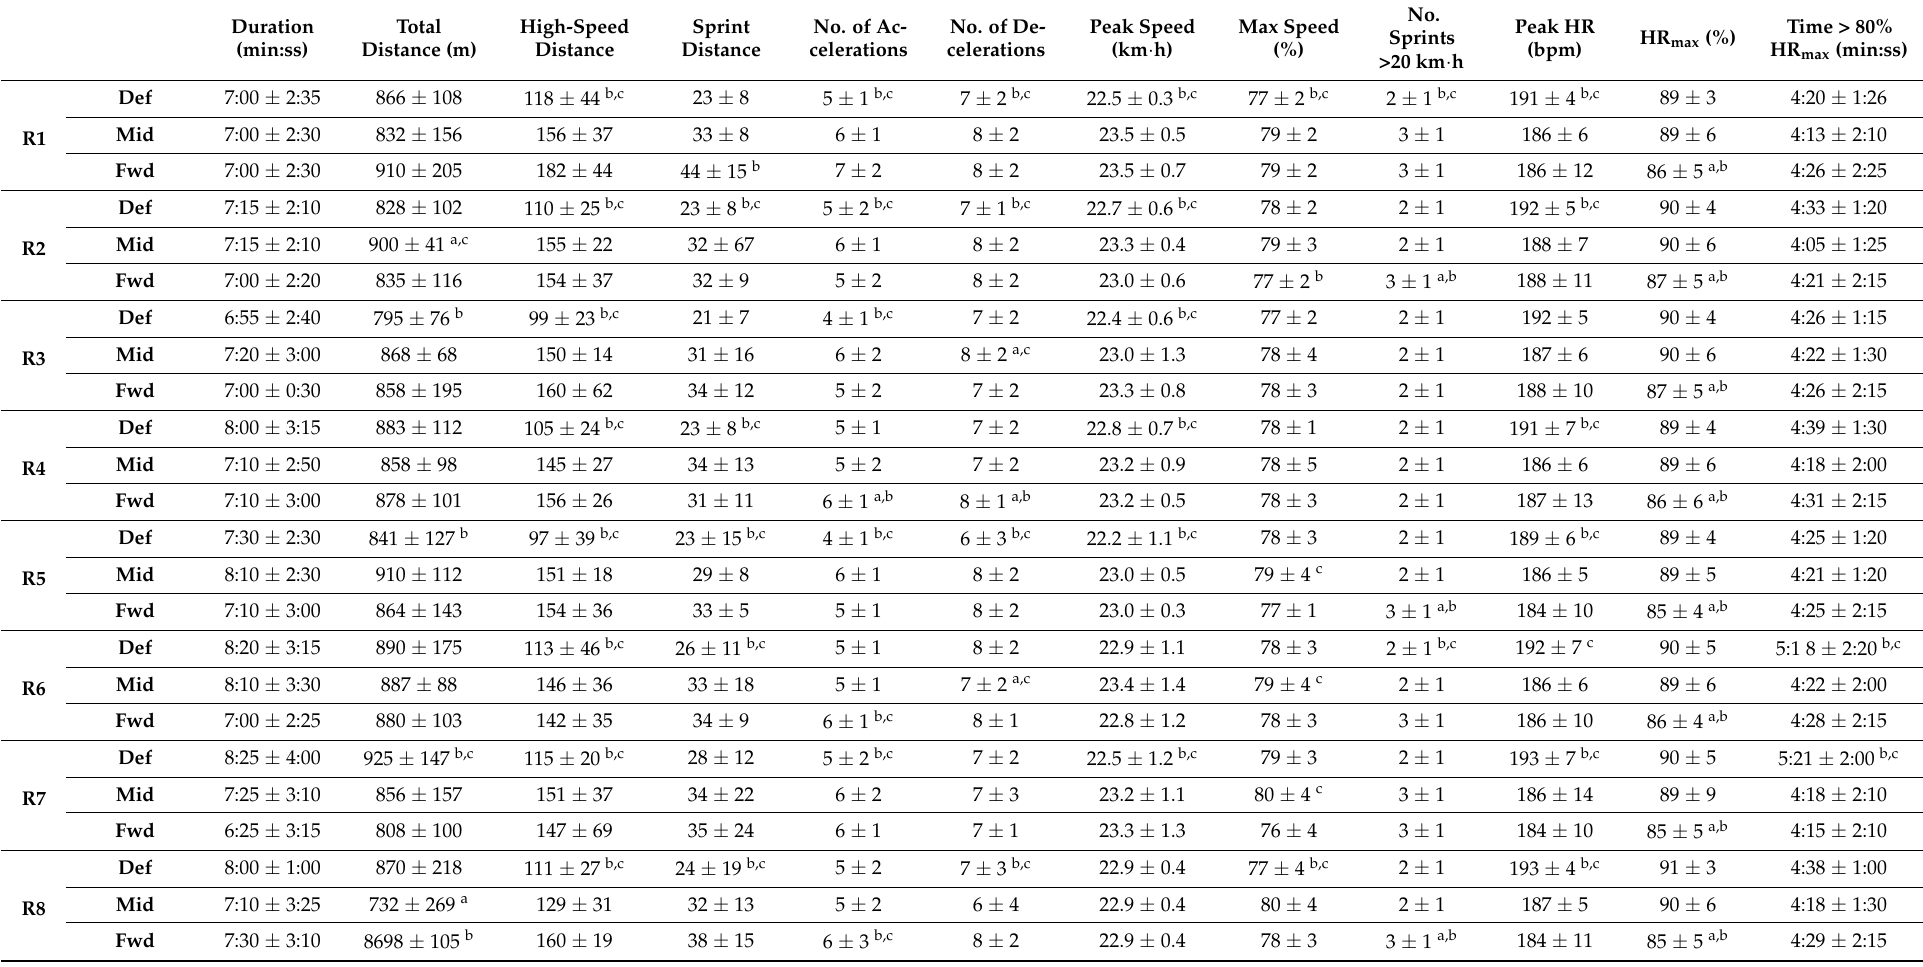
Table 2. The physical and physiological demands of elite international female field hockey during each rotation across the positional lines of play, as determined by GPS technology during match-play. All data are presented as mean ±